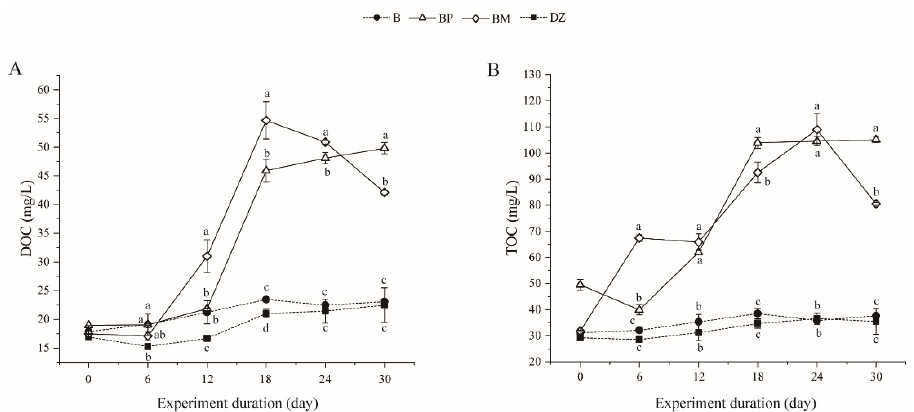
Figure 3. Changes of DOC ( A ) and TOC ( B ) in the water of different groups. Note: group B, a single B. pumilus BP-171, was added; the group BP, B. pumilus BP-171, and PHBV were added; the group BM, B. pumilus BP-171, and molasses were added; the group DZ, the control without any probiotics and carbon sources addition. Values with different superscripts on the same day are significantly different among treatments in each figure ( p <